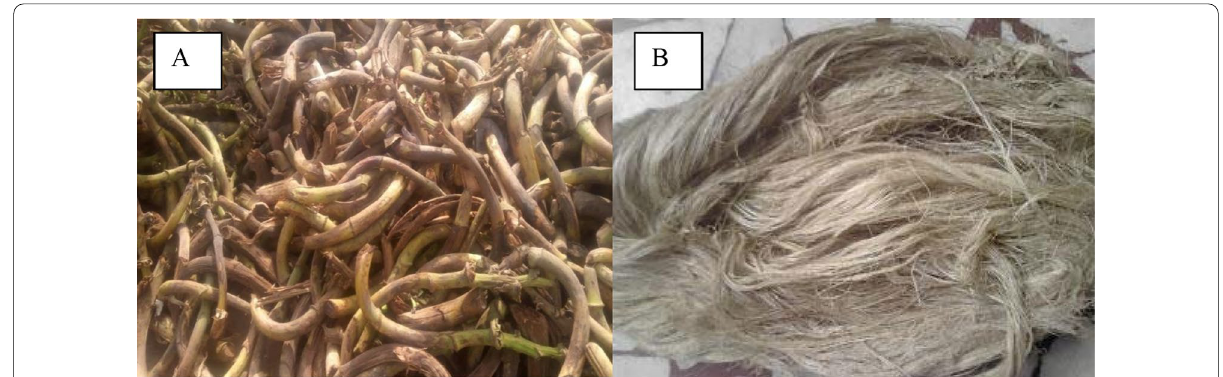
Fig. 1 A Banana peduncles. B Banana peduncle fibre after extraction (Ezeh et al.